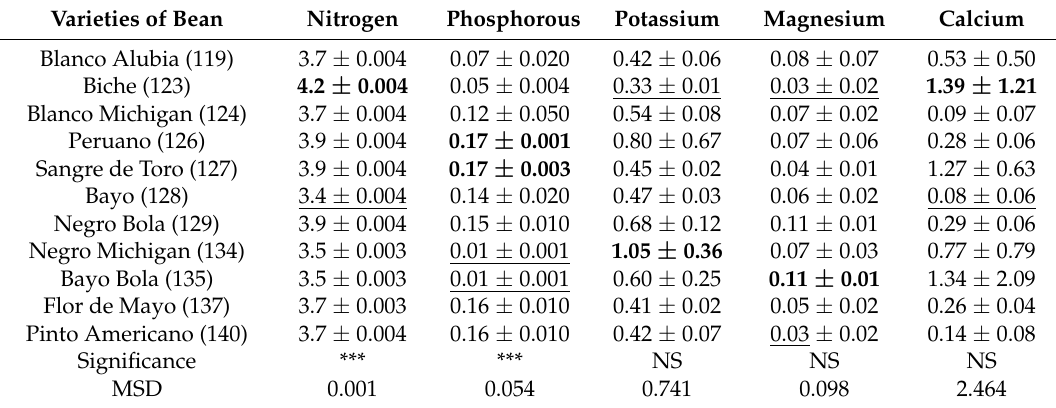
Table 6. Macronutrient Concentrations (%) in bean varieties produced and consumed in the State of